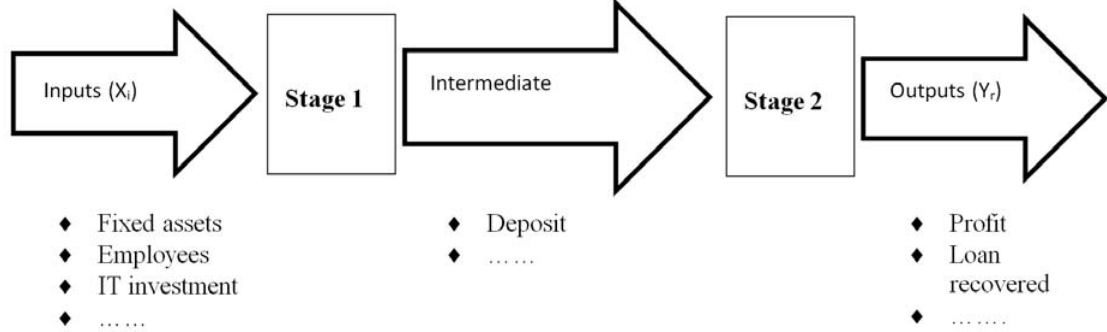
Fig. 2. Intermediate